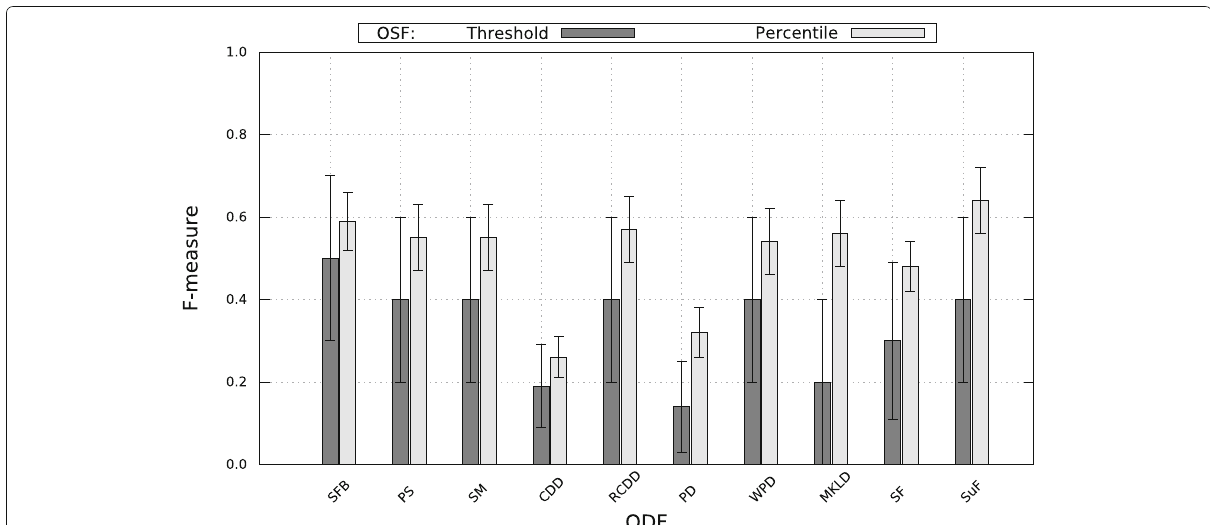
Fig. 5 Graphical representation of the results obtained in terms of F-measure for the static evaluation of the different detection (ODF) and selection (OSF) methods